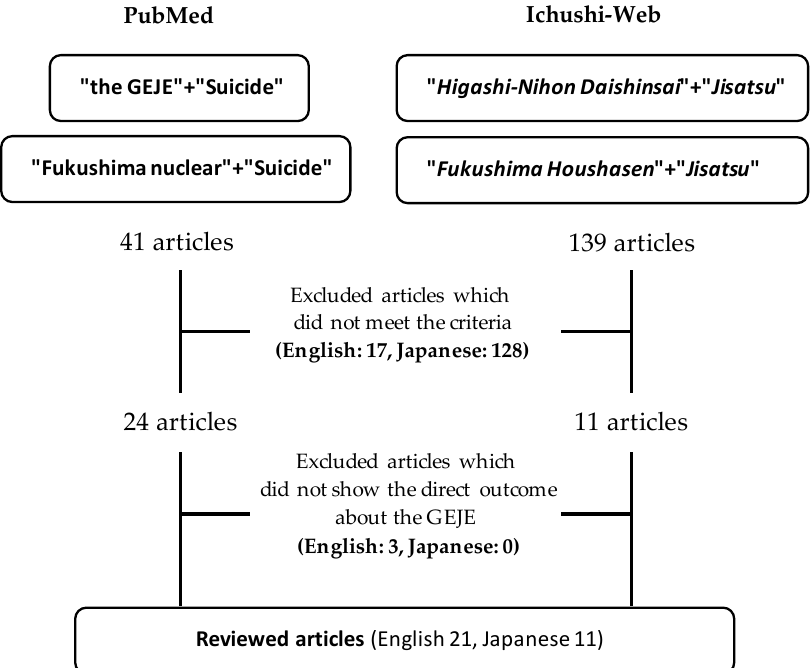
Figure 1. Selection procedure for this literature review.